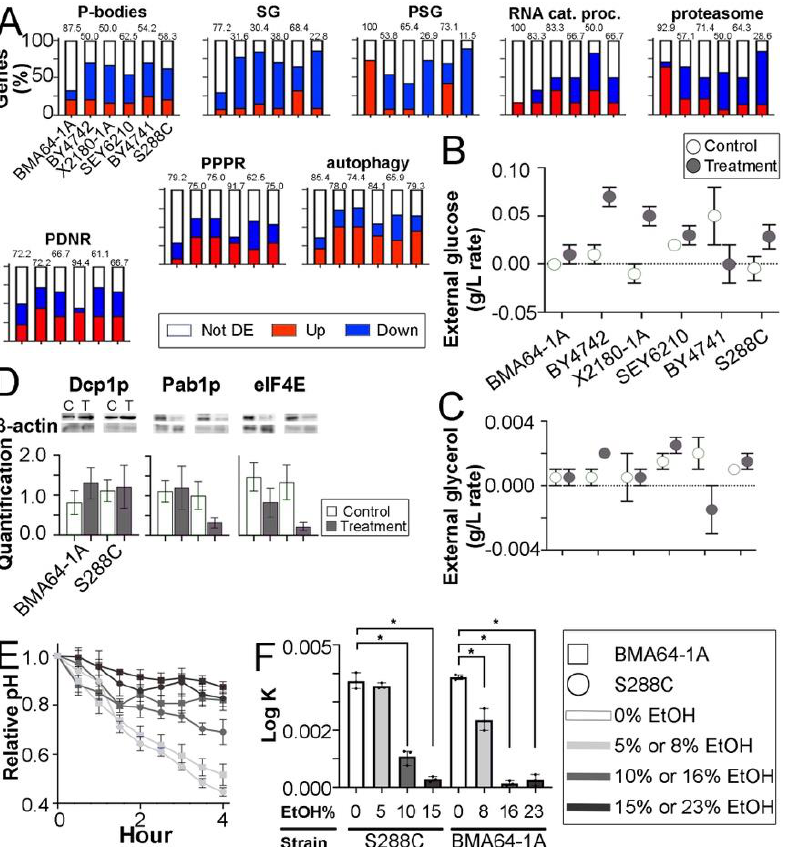
Figure 5. Analysis of genes related to EtOH stress-responsive storage and degradation mechanisms and external conditions of the medium for EtOH-stressed cells. ( A ) The numbers above the bars indicate the percentage of genes related to EtOH stress-responsive storage and degradation systems that were not differentially expressed ( D , E ) or upregulated. PB, P-bodies. SG, stress granules. PSG proteasome storage granules. RNA cat. proc., RNA catabolic process. PPPR, protein polyubiquitination and positive regulation of ubiquitination. PDNR, protein deubiquitination and negative regulation of ubiquitination. The full list of affected genes is reported in the Supplementary Text, ‘Results’, topic ‘4.3.5.’ ( B , C ) Glucose and glycerol levels. Each Y value represents a concentration rate between 1 and 0 h within the control and treatment groups. Therefore, higher values indicate lower glycerol yield or estimated glucose consumption after 1 h. ( D ) Western blot results. C and T over the bands indicate the control and treatment groups. ( E ) Normalized YPD pH level (see Equations (1) and (2) in the Supplementary Text, ‘ Methods ’ , topic ‘ 3.1 ’ ). In the right box is depicted the colors and shapes of this graphic. ( F ) Cell growth in the pH quantification experiment ( E ). *, adjusted p value < 0.0001.